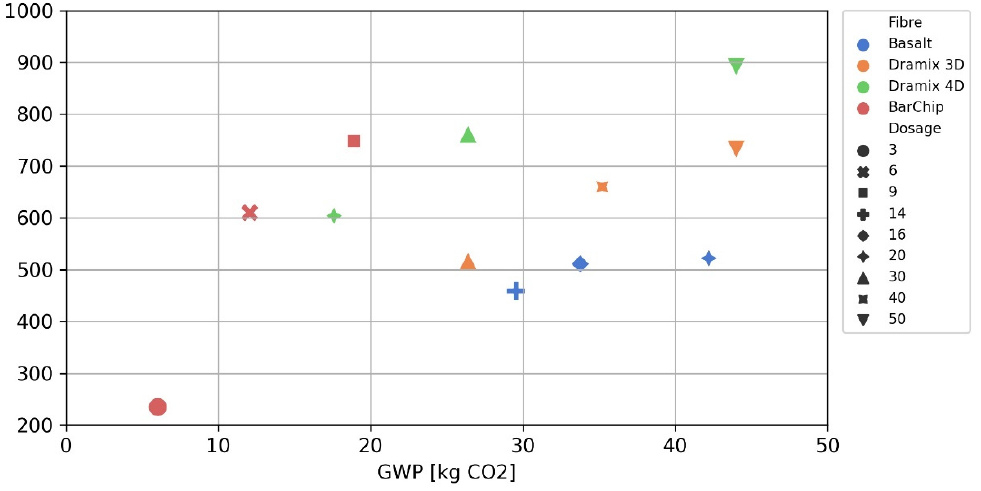
Figure 8. Correlation between the mean energy absorption at 40 mm vertical deflection for a round determinate panel and the global warming potential for all tested fibre types. Dosages are presented in kg/m 3 .